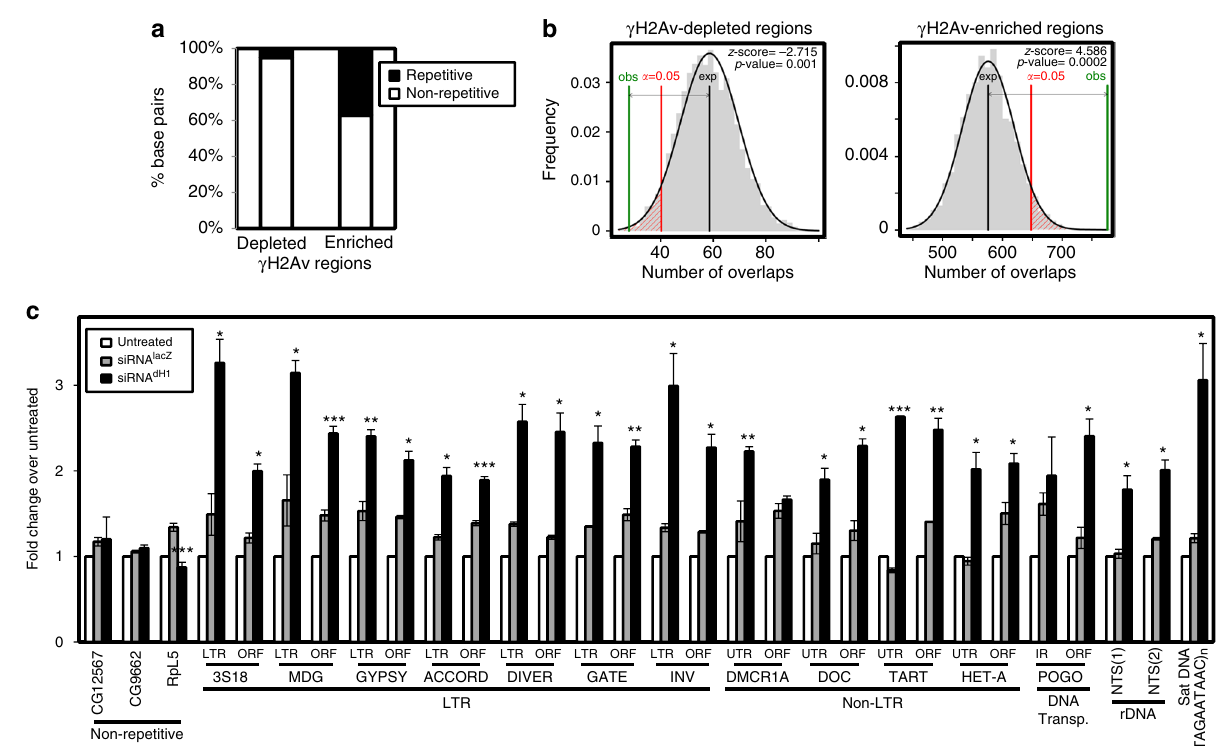
Fig. 2 DNA damage induced by dH1 depletion occurs preferentially in heterochromatin. a The proportion of base pairs (bp) matching to repetitive and non-repetitive elements, as determined by RepeatMasker analysis, are presented for regions showing speci fi c γ H2Av enrichment and depletion in dH1-depleted cells respect to control untreated cells. b Permutation experiments showing statistical signi fi cance of the enrichment in repeated DNA sequences of the regions showing speci fi c γ H2Av enrichment ( right ) and depletion ( left ) in dH1-depleted cells respect to control untreated cells. The frequency of the number of overlaps with repetitive DNA elements, as determined by the regioneR package using the UCSC dm3 RepeatMasker track (March 2017), is presented based on 5000 random permutations of the experimentally identi fi ed regions. The average expected number of overlaps ( black ) is compared with the observed number of overlaps ( green ). The α = 0.05 con fi dence interval is indicated ( red ). z -scores and permutation test p -values of the differences are also indicated. c γ H2Av ChIP-qPCR analyses at the indicated repetitive and non-repetitive regions in siRNA dH1 , siRNA lacZ and untreated cells ( N = 2). For each position, the fold-change respect to the untreated condition at this position is presented. Error bars are s.e.m. The p -values of siRNA dH1 respect to siRNA lacZ are indicated (no asterisk > 0.05, * < 0.05, ** < 0.01, *** < 0.005; two-tailed Student ’ s t